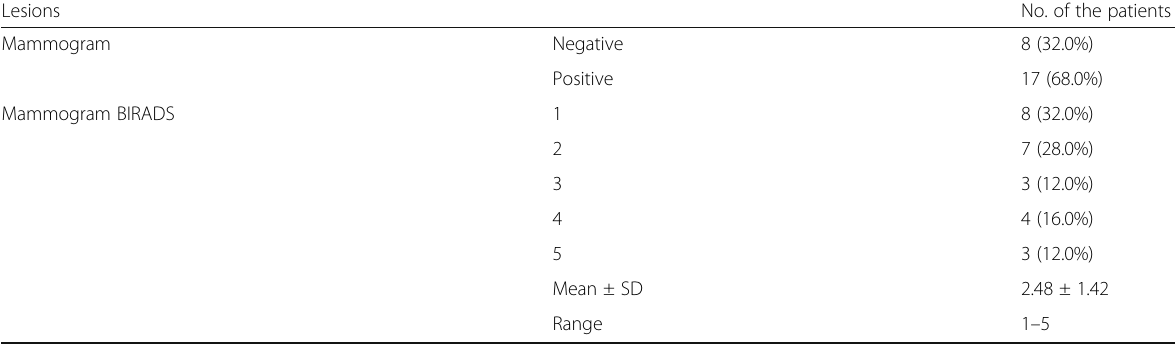
Table 3 Detected lesions by mammogram and correlated BIRADS